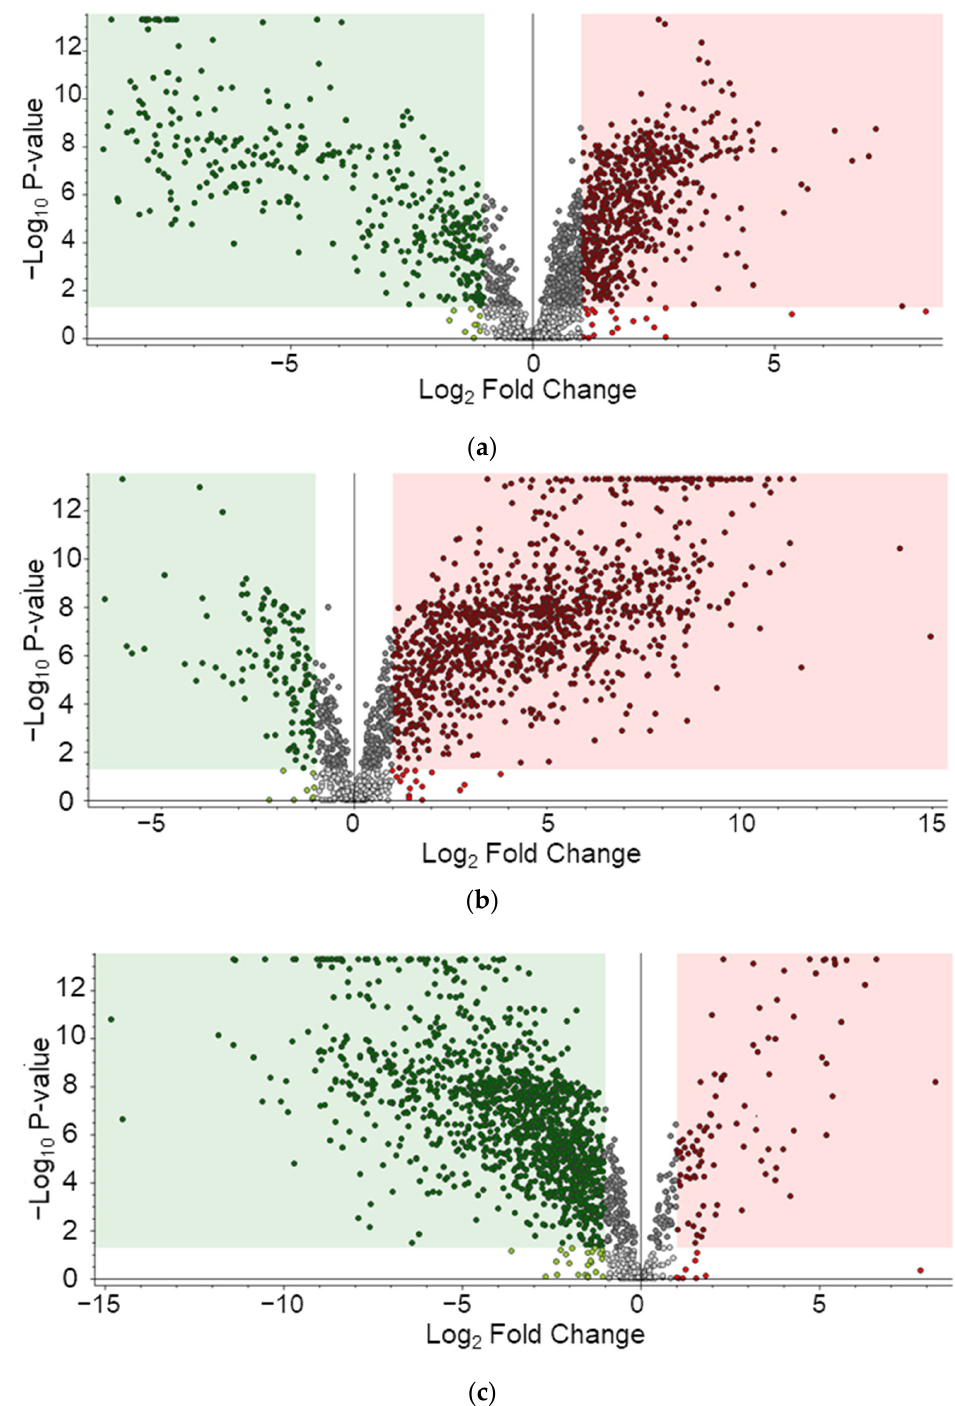
Figure 3. Differentially expressed metabolites. ( a ) Day 5 vs. day 3, ( b ) Day 9 vs. day 5, ( c ) Day 11 vs. day 9.